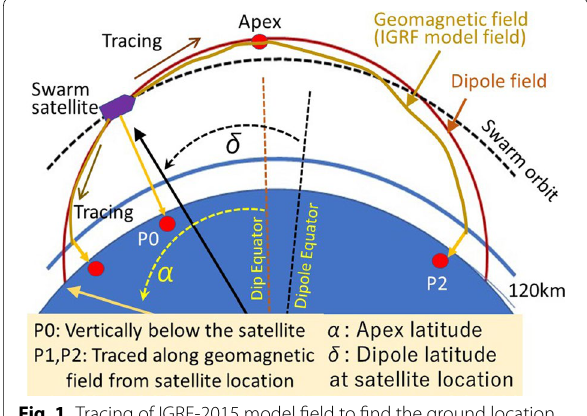
Fig. 1 Tracing of IGRF-2015 model field to find the ground location, P0, P1 and P2, to pick-up the rainfall data and compare with satellite observation. A schematic illustration on the relation among ’dipole equator’, ’dip equator’, ‘dipole latitude; δ’ and ‘Apex latitude; α’. Apex 1 ( √ ( 1 / La )) , where La is the L value at cos latitude is defined as α − = the Apex point, which is defined as the most distant point from the center of the Earth, along a geomagnetic field line of